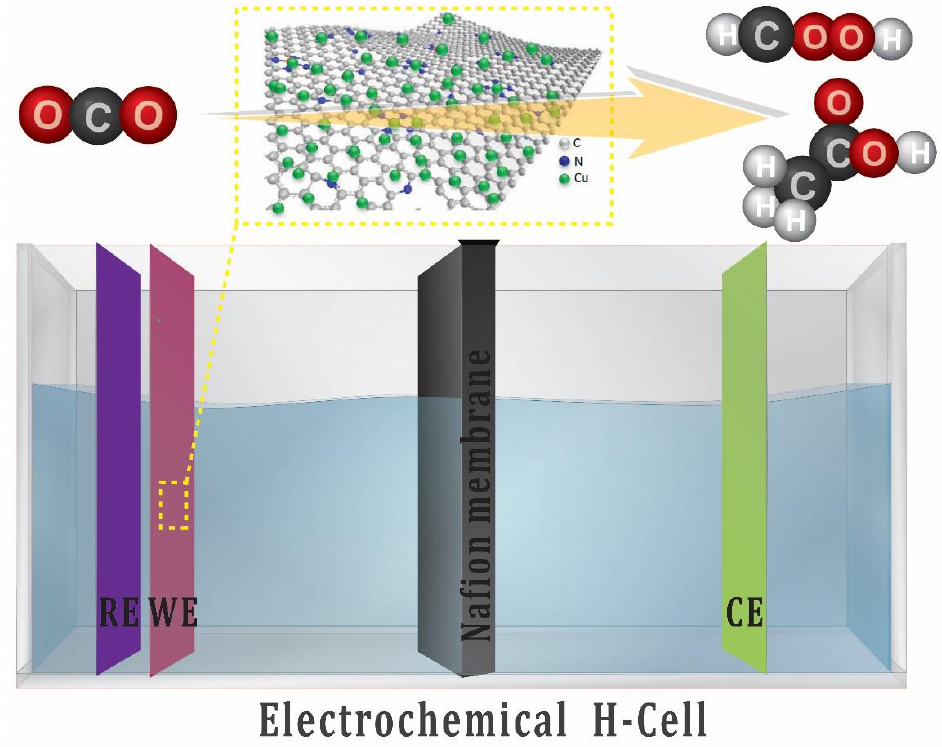
Figure 1. Schematic presentation of the three-electrode setup (H-Cell) for electrochemical CO 2 re- duction.